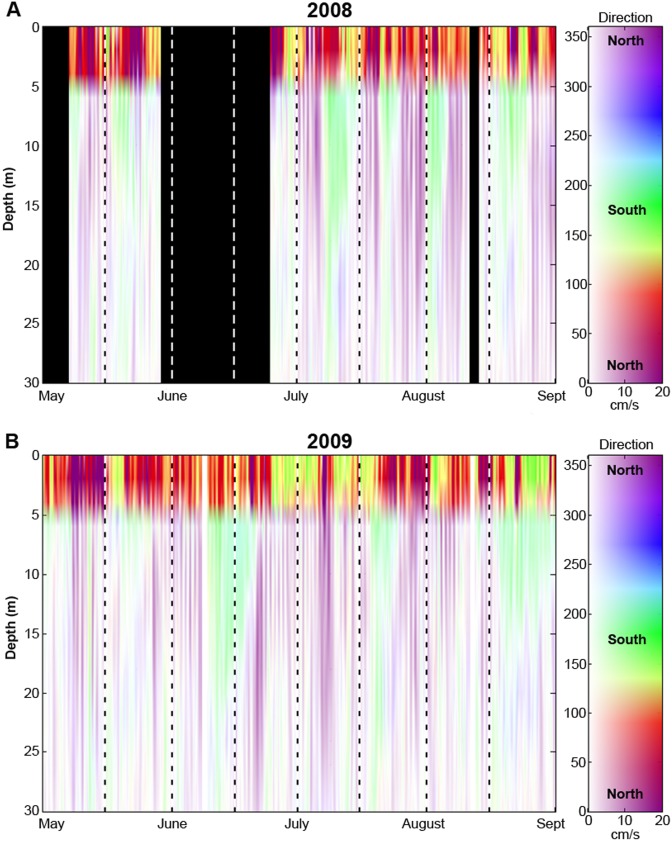
Acoustic Doppler Current Profiler (ADCP) data from 2008 (Fig. 5A) and 2009 (Fig. 5B).Purple colors indicate northerly flowing currents, green colors indicate southerly flowing currents, and red colors indicate onshore flow. Intensity of color represents magnitude of flow. Black regions represent periods of time when ADCPs were not collecting data.